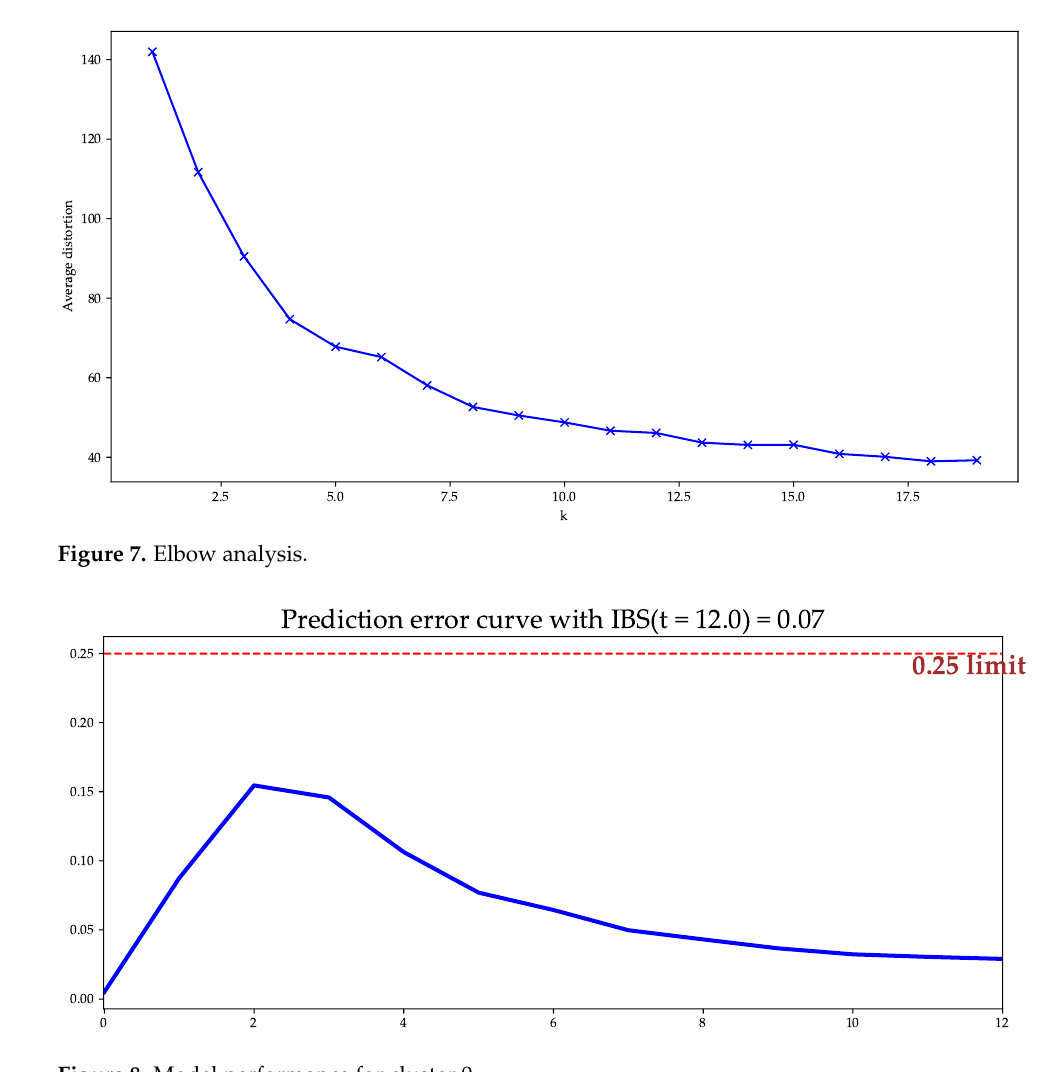
Figure 8. Model performance for cluster 0.